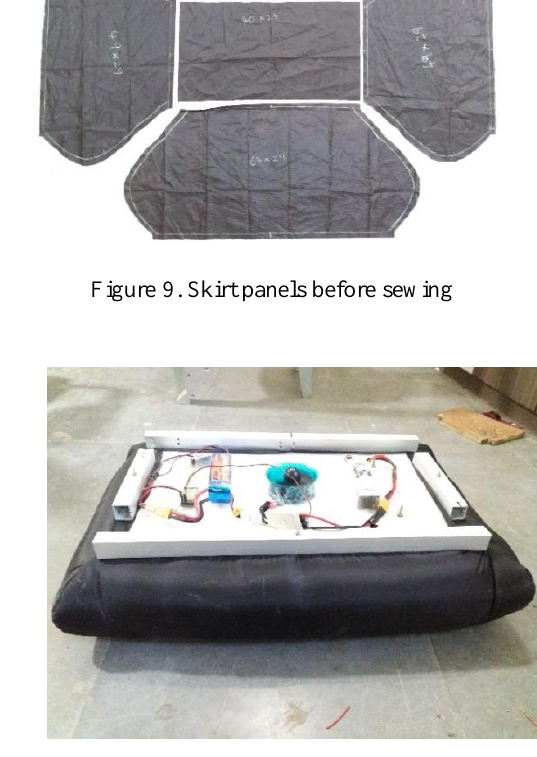
Figure 10. Holes punched underneath of skirt Figure 11. Skirt attached with